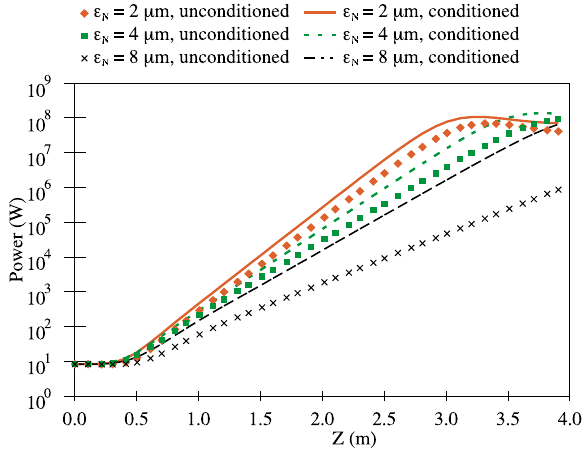
FIG. 1. (Color) Radiation power as a function of undulator length in theVISA FEL. Conditioned and unconditioned beams at different emittances are compared.